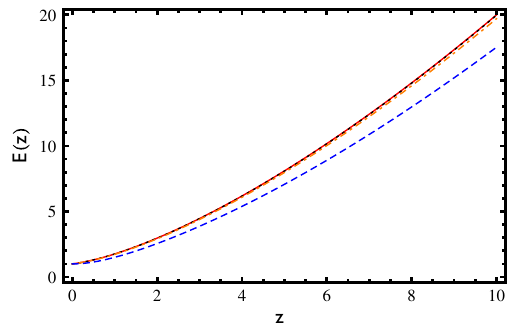
Fig. 1 The effects of the bulk viscosity coefficient η on the dimension- lessHubbleparameter E ( z ) intheV (cid:4) DEmodel.Herewehaveassumed (cid:11) = 0 . 3 and the solid (red), dotted (black), dash-dotted (orange) and m dashed (blue) lines correspond to the cases of η = 0 ( (cid:4) CDM), 0.003, 0.03 and 0.3,